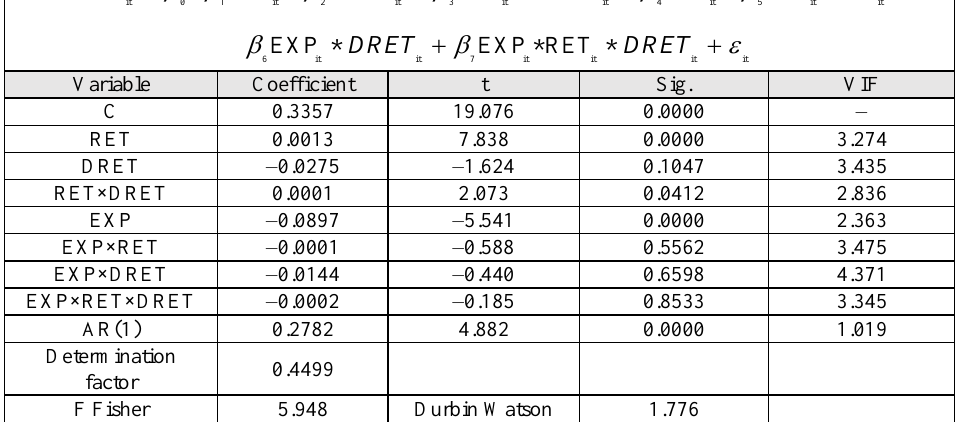
Table 4: Results of statistical analysis for hypothesis 1 (Basu’s developed